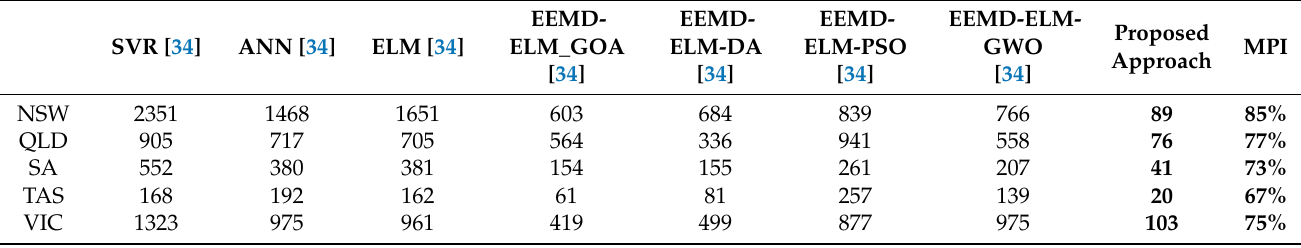
Table 6. Performance criteria in terms of RMSEs for electrical load prediction data in five regions of Australia (test data). The best results are highlighted in bold and MPI represents the minimum percentage